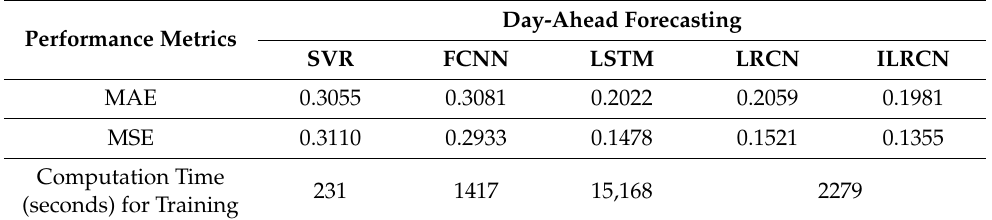
Table 5. Performance metrics of different models for day-ahead forecasting. Performance